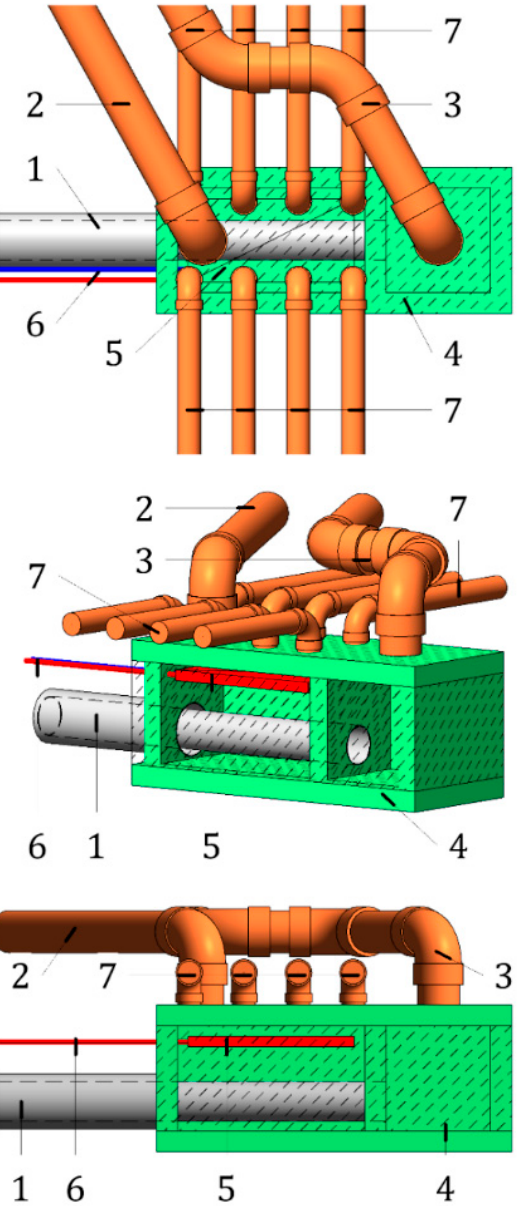
Figure 15. Chamber of pooled air distributor and air collector for ventilation with heat recovery with installed water/air exchanger. 1—heat recovery heat exchanger pipe-in-pipe; 2—supply of treated air to the building; 3—air exhaust from the building; 4—chamber of the distributor and collector of ventilation air; 5—liquid heat exchanger of water-air type; 6—the heat transfer medium’s supply and return; 7—supply pipes of treated air on the first